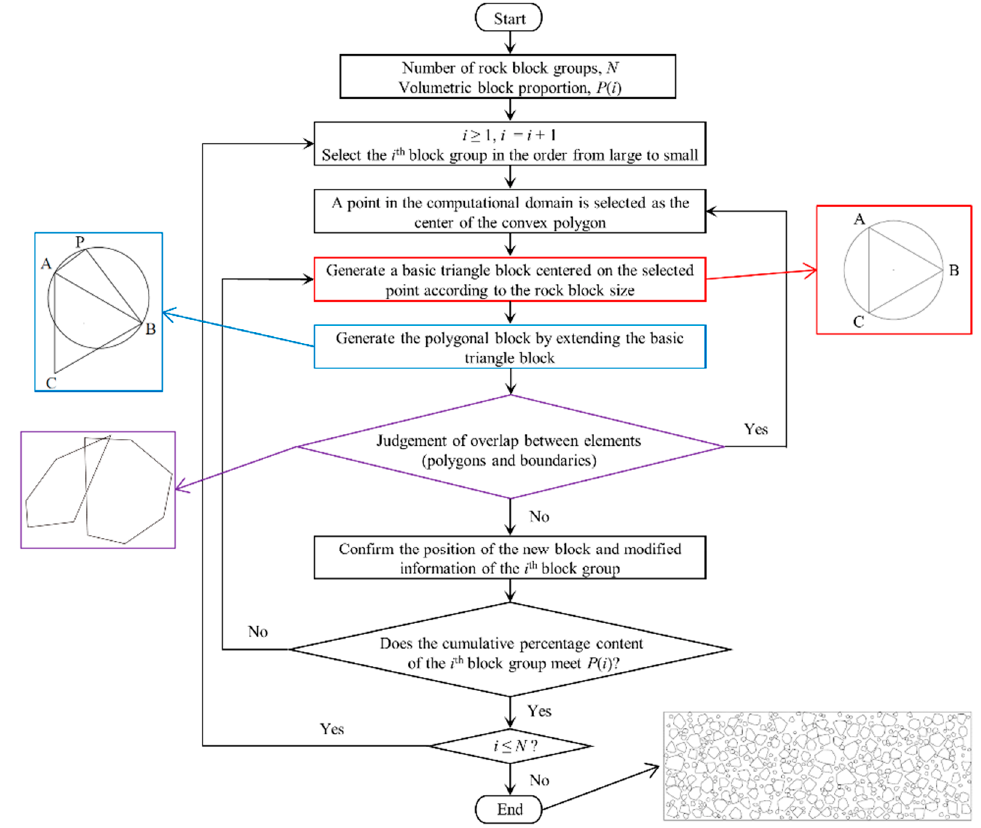
Figure 1. The procedures of generating polygons to model rock